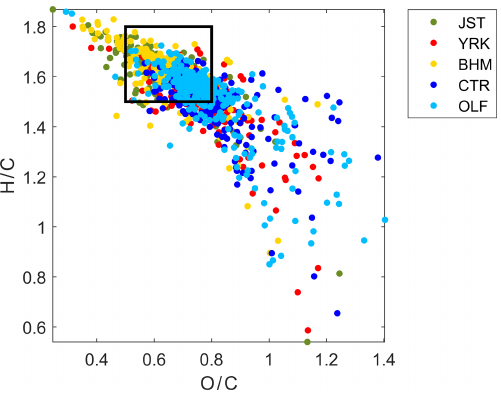
Figure 6. Ratios of H / C and O / C measured in SEARCH ambient samples using FT-IR spectrometry models, plotted in the van Krev- elen space. The bold black box surrounds the data range collected using aerosol mass spectrometry in the southeastern US during the summer of 2013 (Xu et al.,